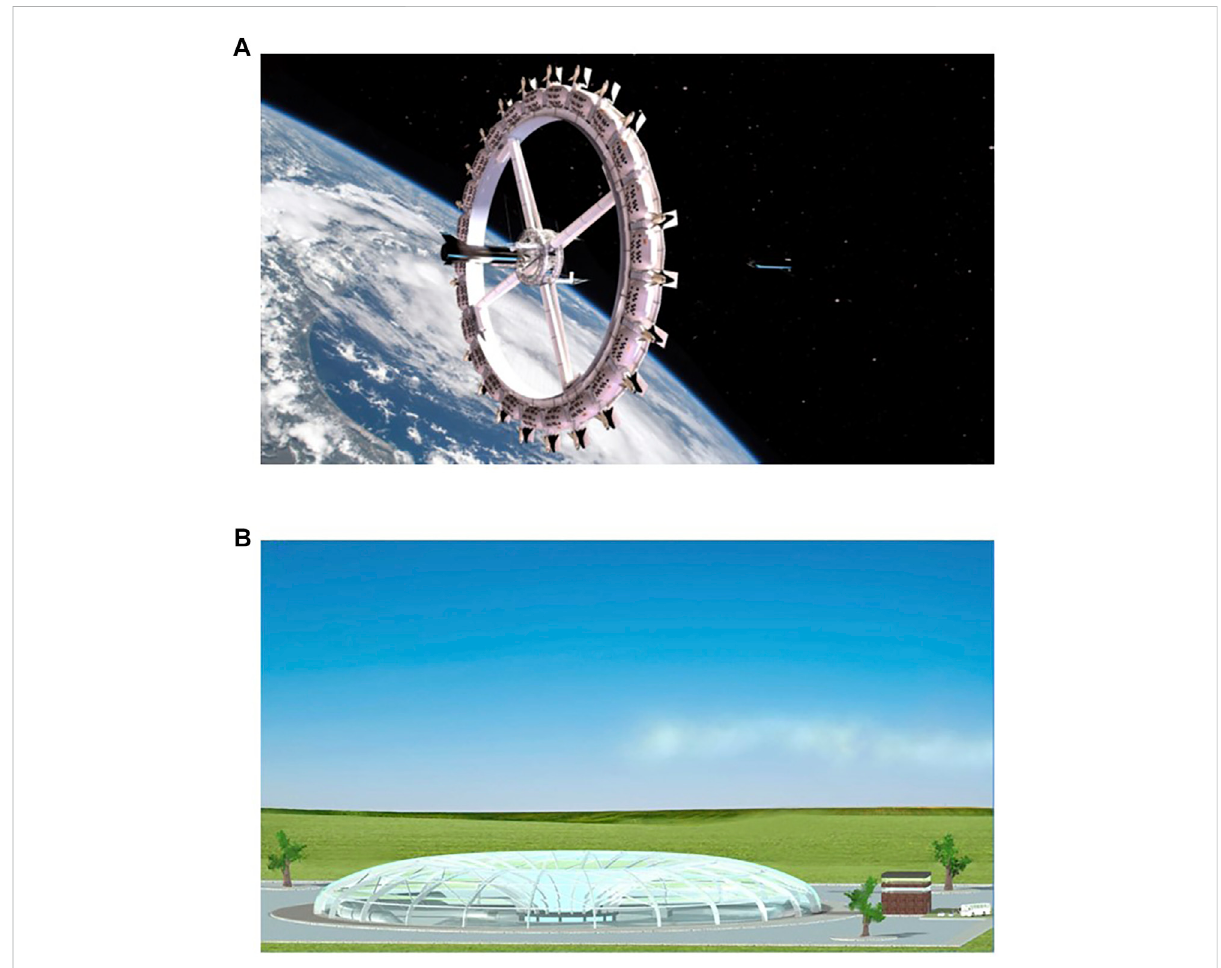
FIGURE 6 (A) TheVoyager-classspacestationasproposedbyOrbitalMechanicscompany(Fontana,CA,UnitedStates).Thiswouldbea~200-mdiameter continuous gravity (1/3 g) space station/space hotel planned for operation in 2027. (Image courtesy: Orbital Assembly, Huntsville, AL United States)) (Spilker, 2020). (B) A large arti fi cial gravity platform; the Human Hypergravity Habitat, H 3 ; a proposed ground-based facility that could be used to obtain operational data regarding long duration/continuous rotation and moderate hyper-g on human physiology and psychology (van Loon et al.,